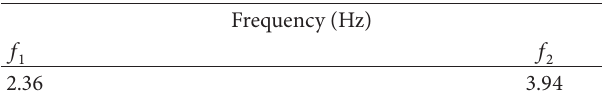
Table 1: Frequency values of free vibration